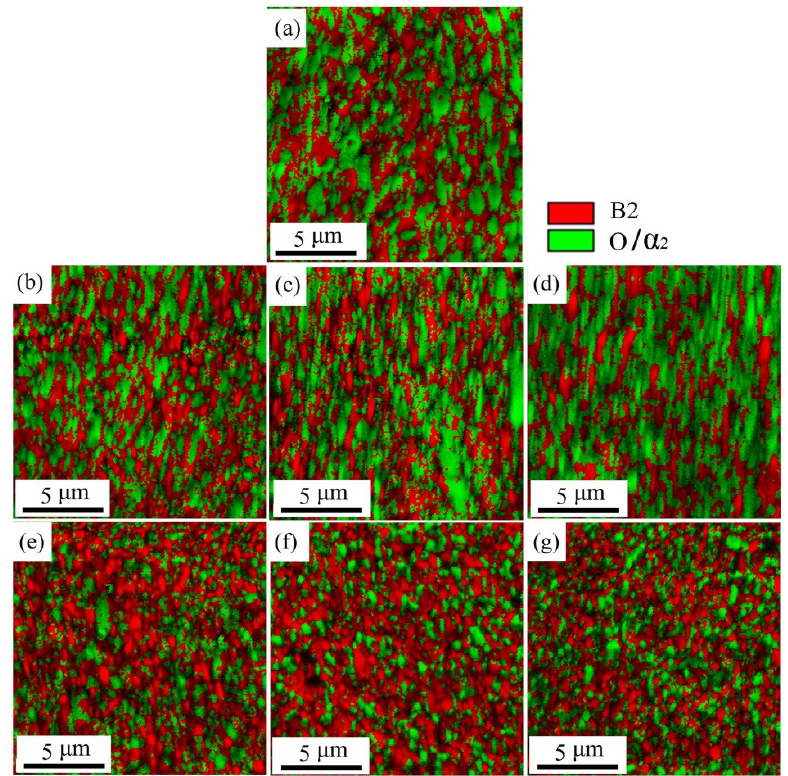
Figure 6. IQ + Phase figure of BM of Ti 2 AlNb alloy spun workpiece formed at different passes: ( a ) initial welded tube, ( b ) pass 1st, ( c ) pass 2nd, ( d ) pass 3rd, ( e ) pass 4th, ( f ) pass 5th, ( g ) pass 6th.